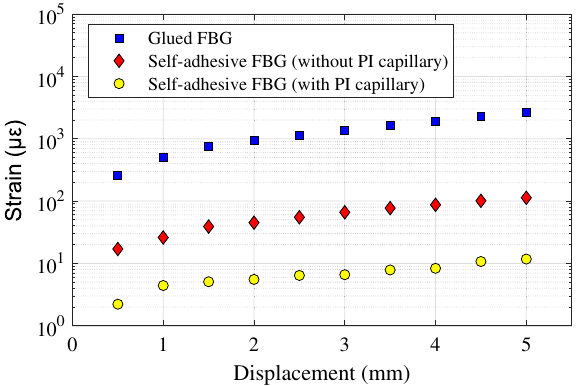
Figure 10. Comparison of the strain measured by the self-adhesive FBG sensors with and without PI capillary, and the reference strain obtained by a glued FBG